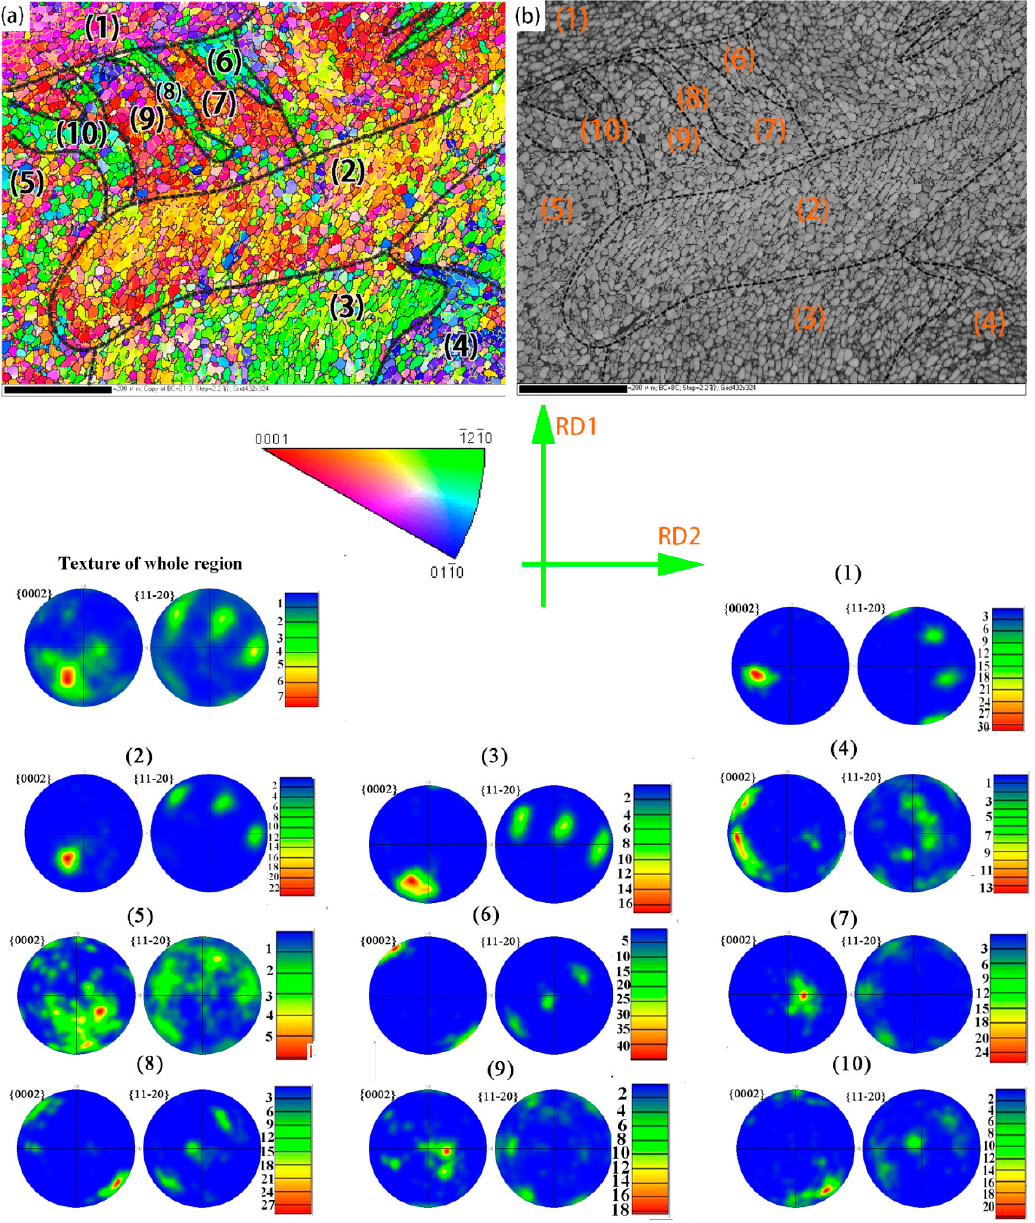
Figure 4. The characterization of the Ti6242S billet characterized by EBSD: ( a ) IPF and ( b ) BC maps of the RD1–RD2 plane in cross section. The maps can be divided into ten sub-regions (1–10). The corresponding pole figure of the whole scanning region is displayed below the IPF maps. Pole figures of subregions 1–10 are displayed below. The triangular color key corresponds to the IPF map. The coordinate system indicates the two arbitrary perpendicular radial directions (RD1 and RD2) in all maps and pole figures.